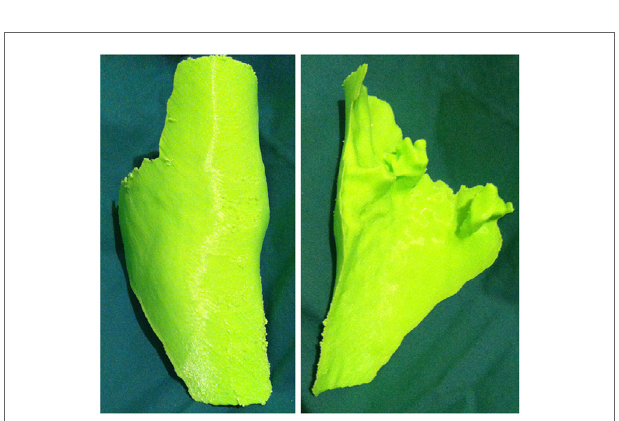
FiGURe 6 | 3D-printed haptic model of the “reverse” image representing the wound defect . Reproduced with permission from Microsurgery